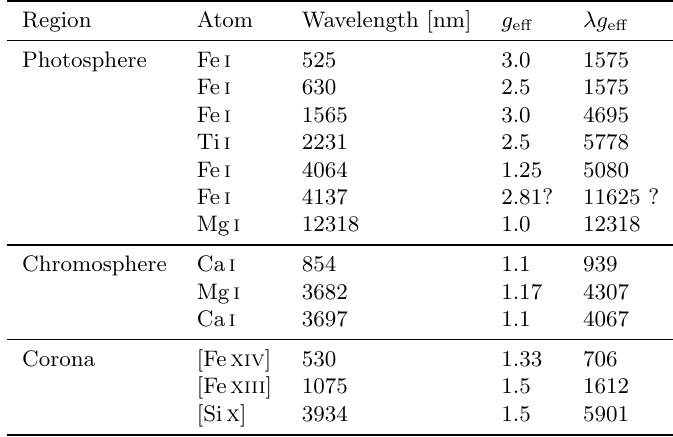
Table 2: Magnetic Sensitivity of Spectral